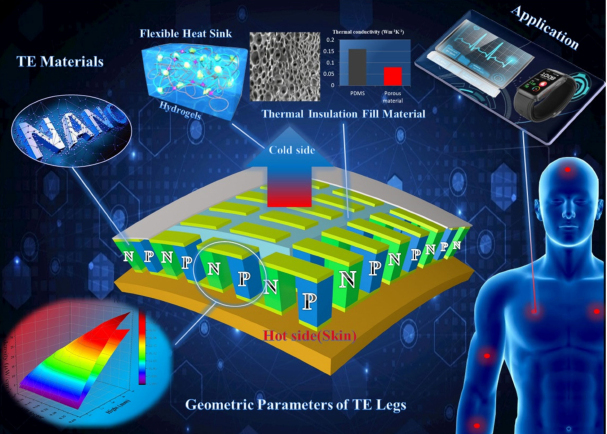
Figure 1. A schematic diagram showing the structure, optimization strategy, and applications of